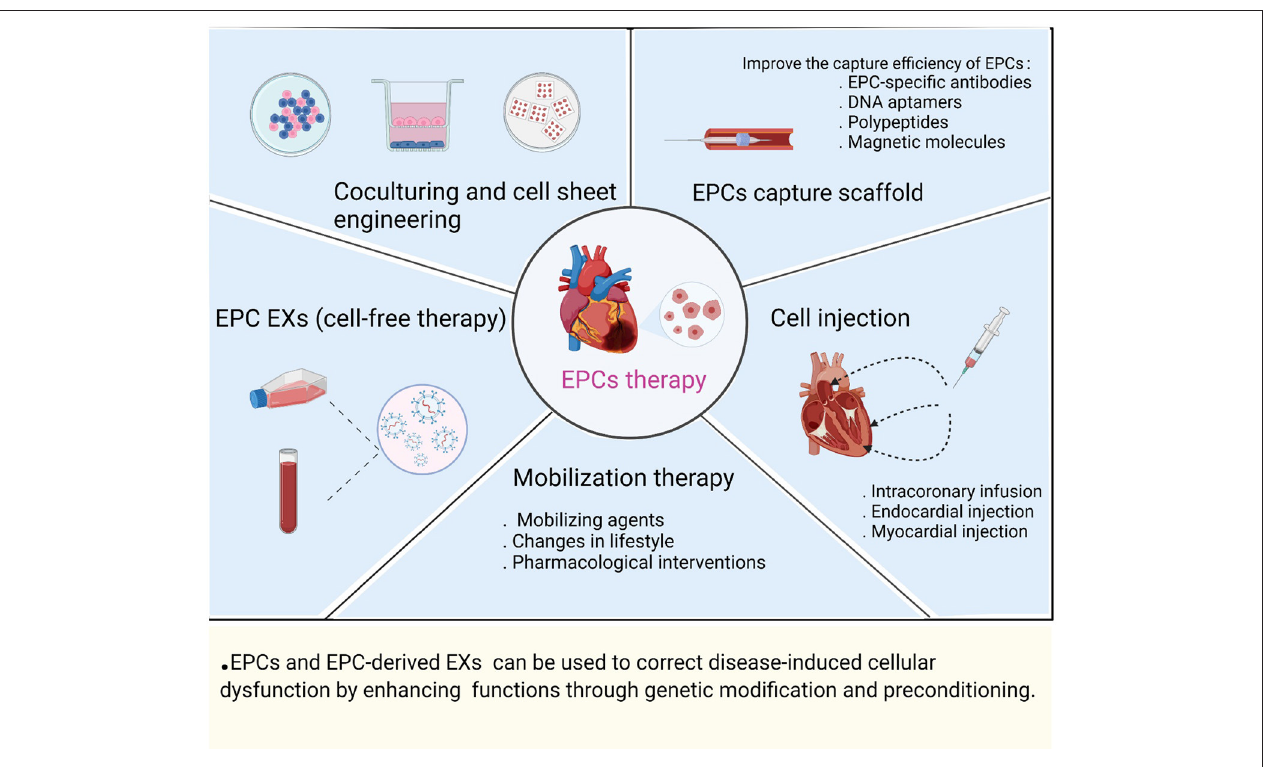
FIGURE 3 | Preclinical and clinical applications of EPC